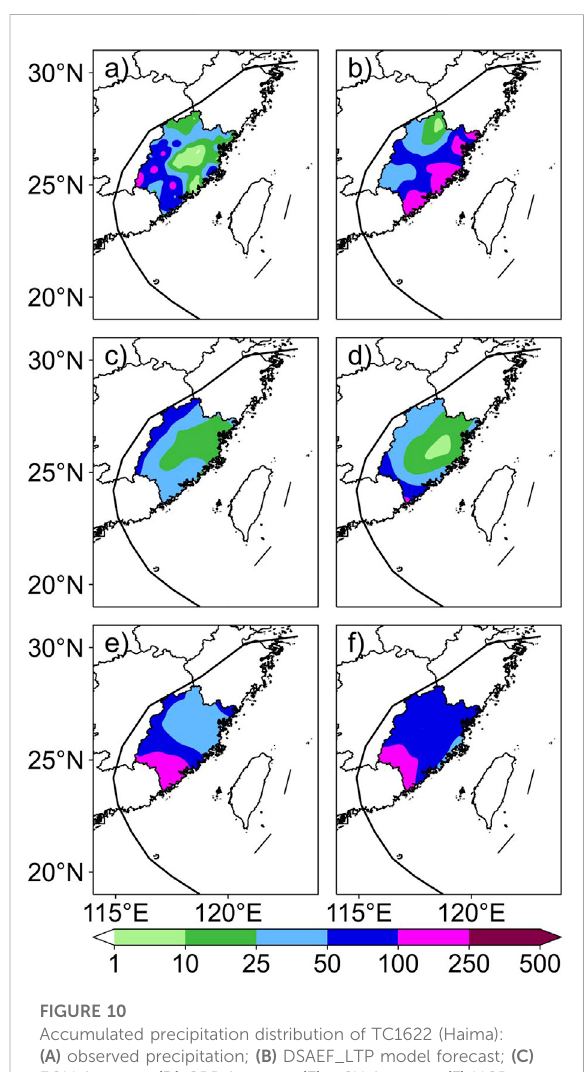
FIGURE 10 Accumulated precipitation distribution of TC1622 (Haima): (A) observed precipitation; (B) DSAEF_LTP model forecast; (C) ECM forecast; (D) GRP forecast; (E) mSH forecast; (F) NCP forecast. The black solid line is the observed